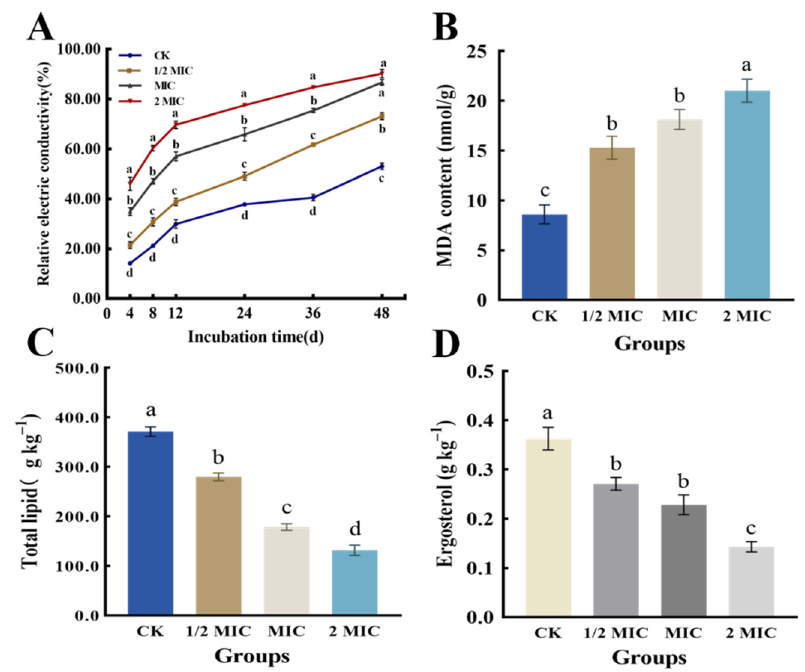
Figure 4. Effects of PCT nanoemulsions on the ( A ) relative electric conductivity and ( B ) MDA, ( C ) total lipid, and ( D ) ergosterol content of P. italicum mycelia at concentrations of 0, 1/2 MIC, MIC, and 2 MIC. Each value represents the mean ± SD. Means with different letters were significantly different at p <